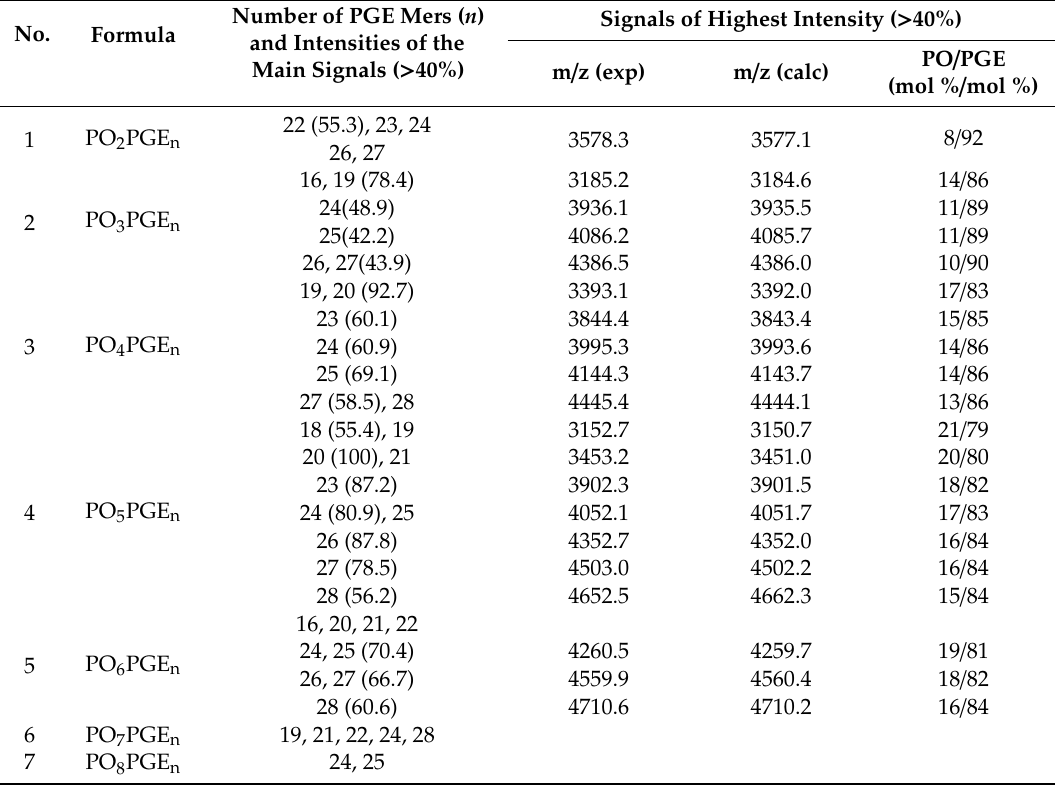
Table 9. Composition of PO / PGE random copolyether–diol (22) determined by MALDI-TOF mass spectrometry.